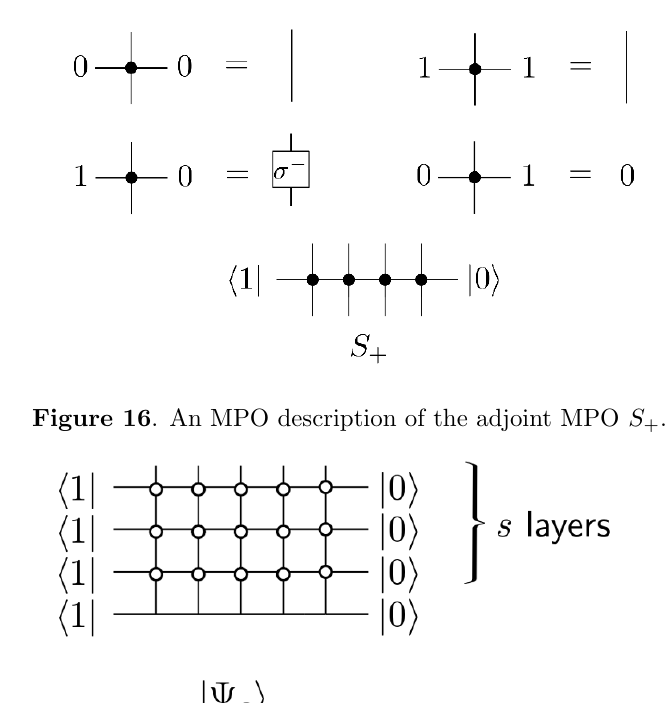
j (cid:9) i . Seen as an MPS, this has (cid:0)